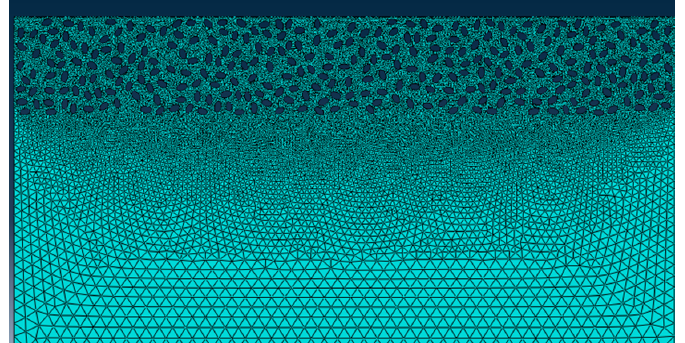
Figure 8. Matrix meshing.